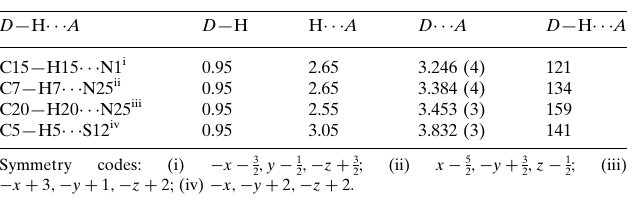
Hydrogen-bond geometry (A˚ , (cid:2)